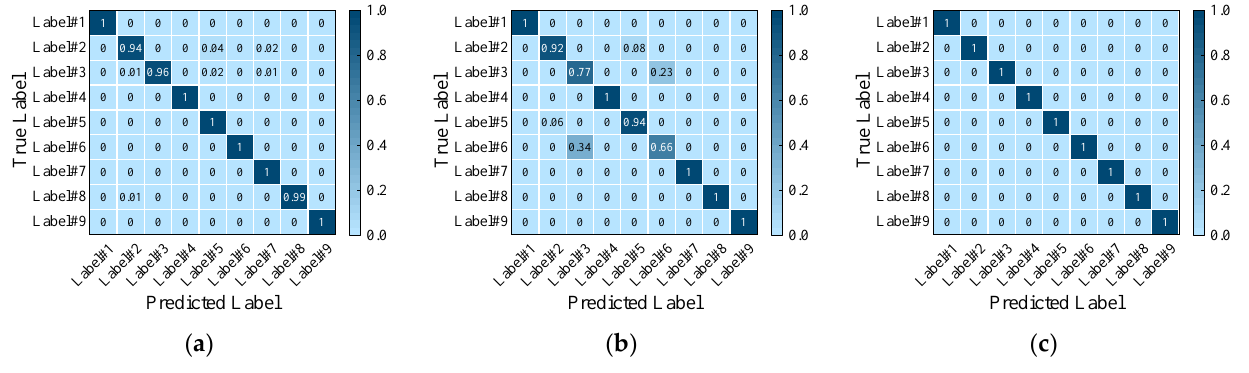
Figure 14. Confusion matrix of the target dataset, when 50% of the training dataset is target domain samples: ( a ) time domain diagram; ( b ) frequency domain diagram; ( c ) time-frequency diagram. The feature embedding of source and target domain from DANN with t-SNE [29] for both two datasets are visualized in Figure 15, and different fault types are indicated by different color symbols. T-SNE can visualize the high-dimensional data by mapping samples from the original feature space to two-dimensional space. Compared with the results of source domain Figure 15a,c and target domain Figure 15b,d, it shows obvious clustering and separability between source domain and target domain, which is sufficient to show that the proposed network can reliably perform cross-domain fault diagnosis when there are fewer available samples. The same fault labels of the source and target domains that do not pass feature mapping and those that pass feature mapping are projected to the same region, indicating that the same fault labels of the source and target domains are similar to some extent.